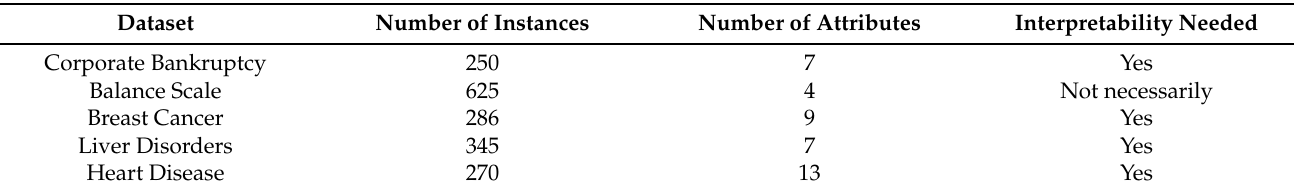
Table 4. Binarizing categorical features in the Bankruptcy